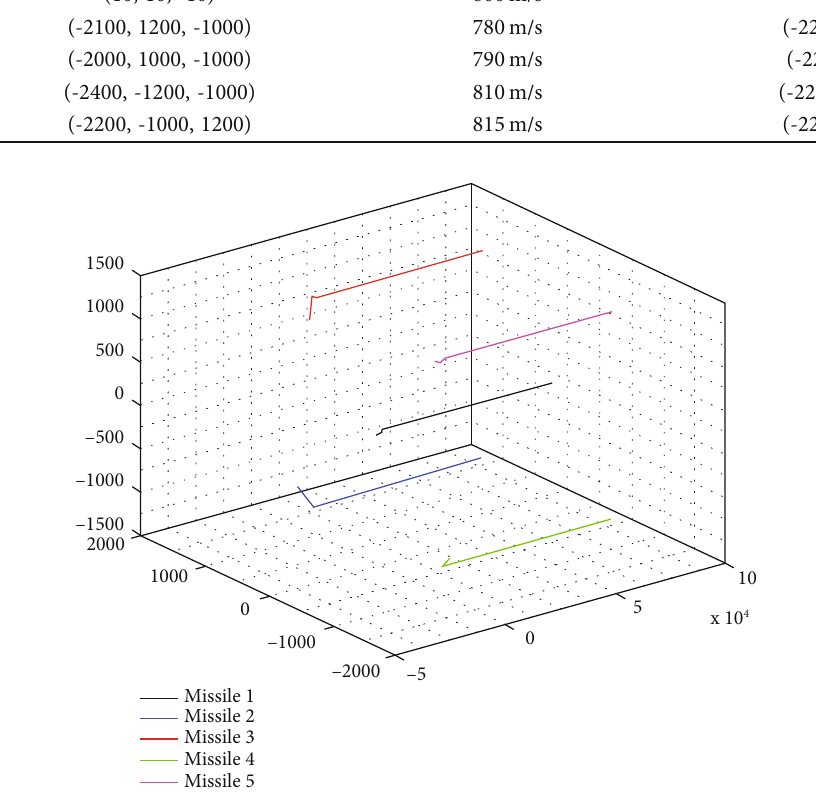
Figure 2: Relative trajectory of formation missiles.